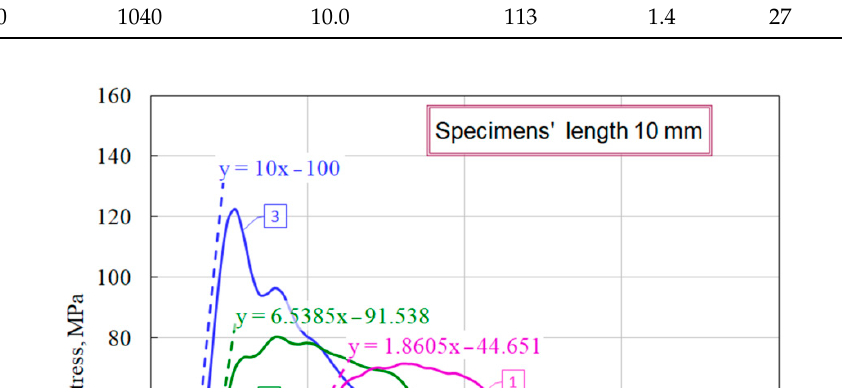
Figure 8. Definition the stress growth rate.